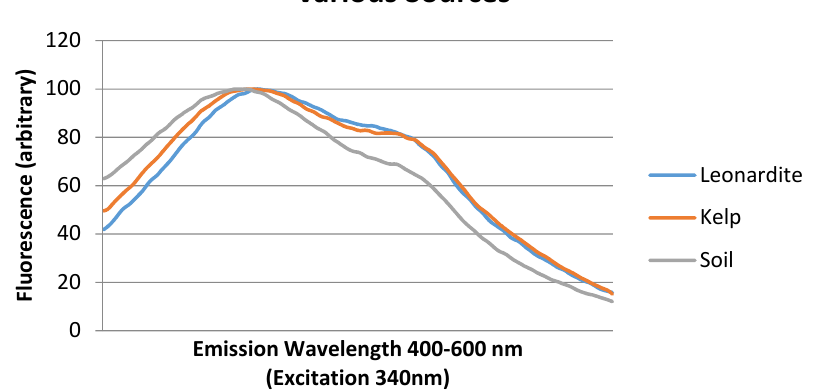
Figure 1. Fluorescence spectra of humic acids extracted from soil, kelp, and a commercial humic acid (sourced from Leonardite coal).